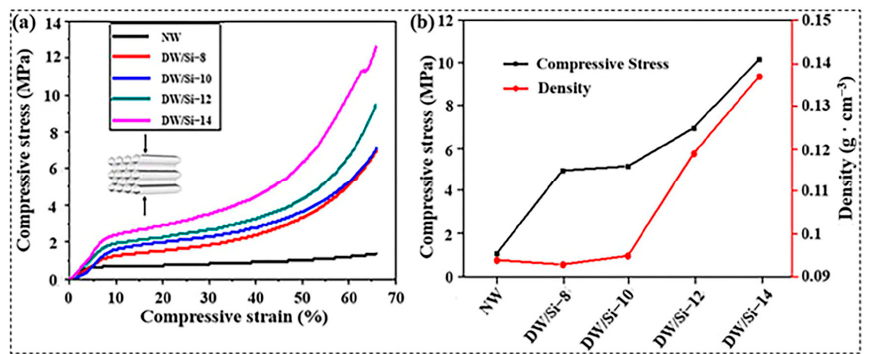
Figure 5. ( a ) Stress − strain curves of the samples (inset is the s chematic of compression test) and ( b ) elastic modulus and strength at 60% compression of the NW and DW/Si-x aerogels. ( b ) elastic modulus and strength at 60% compression of the NW and DW/Si-x